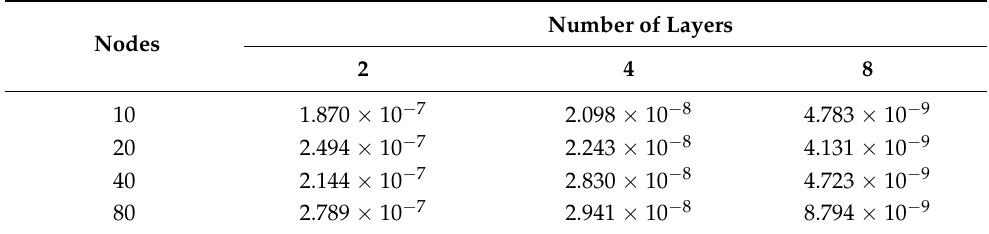
Table 2. Results of the mean square error analysing of varying number of nodes in a layer and number of layers in the